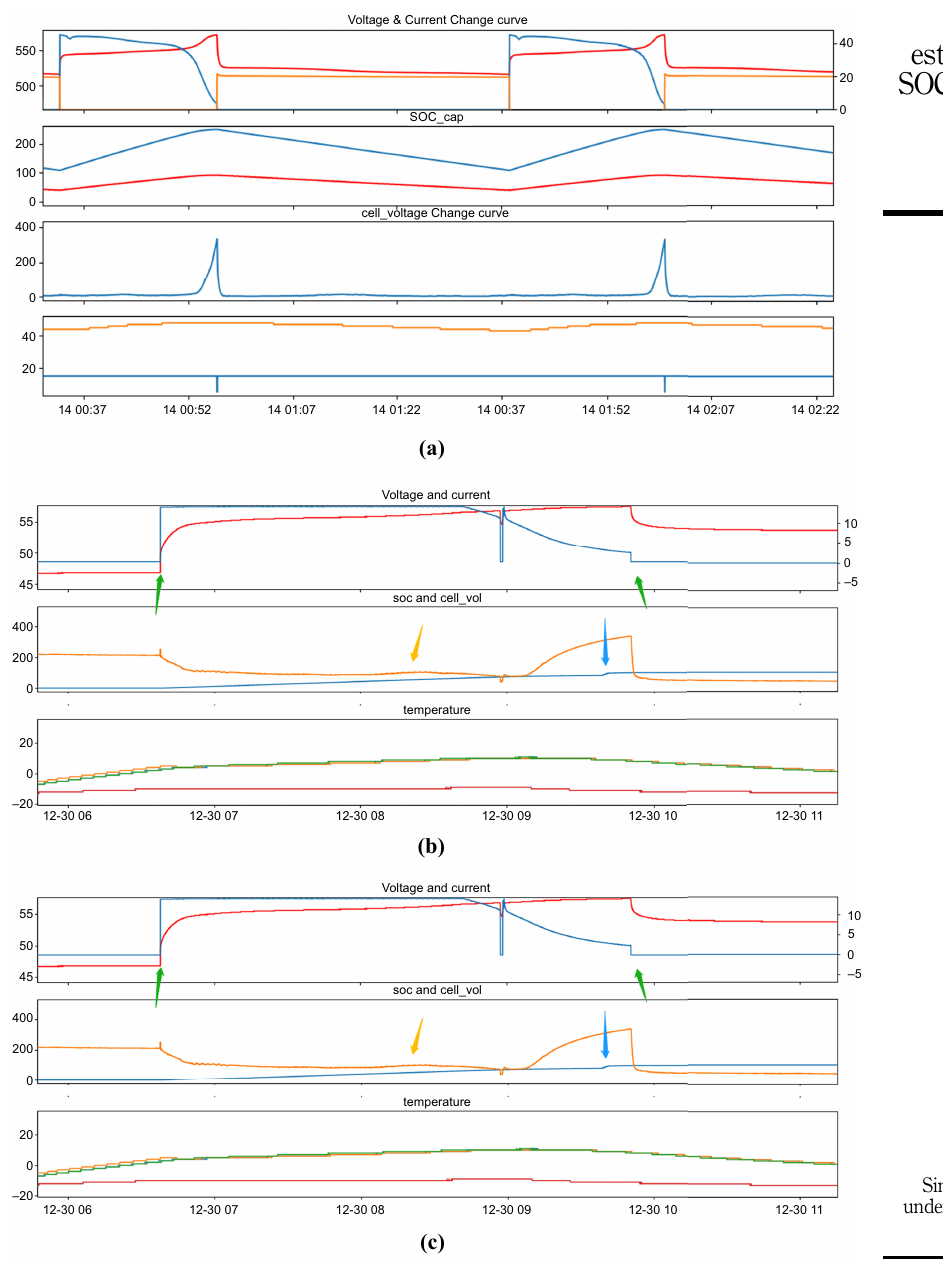
Figure 6. Simulation results under three working